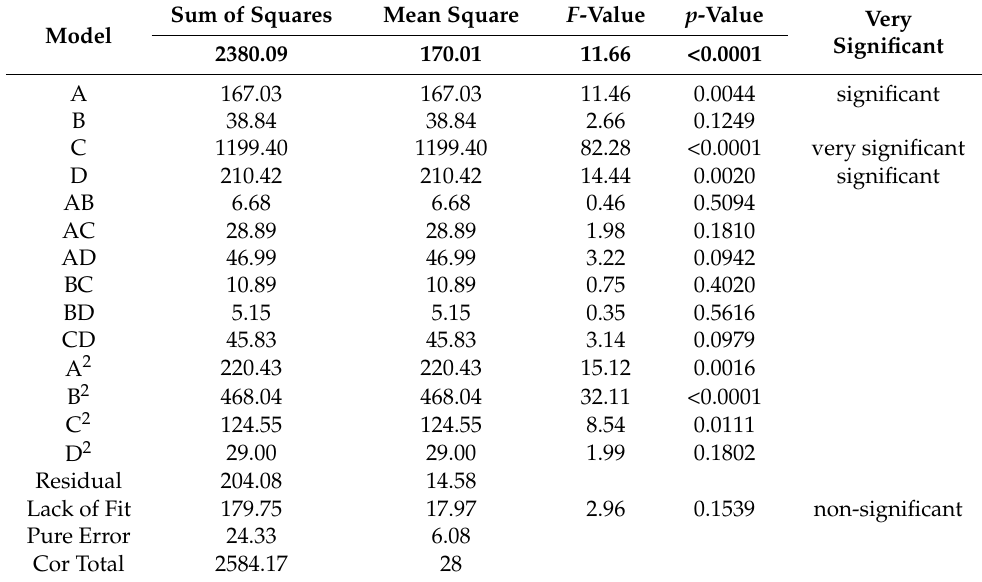
Table 2. ANOVA and fit statistics of the quadratic model for synthesis of isopropyl myristate.